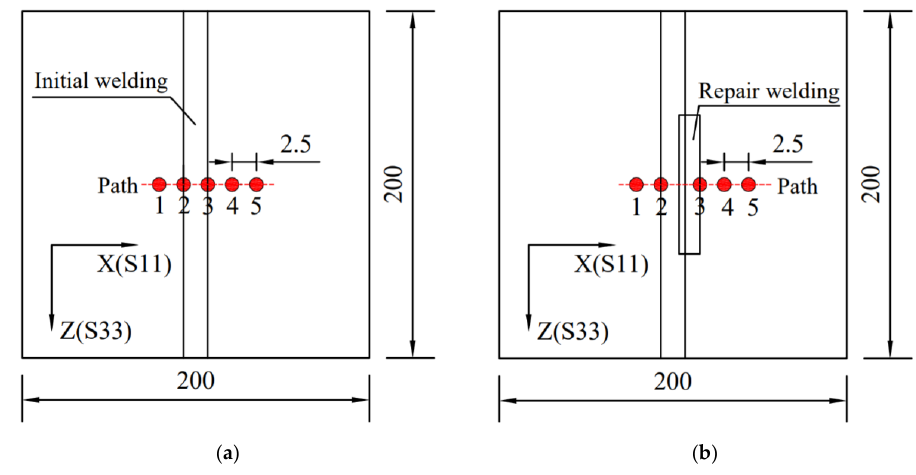
12 of 26 Figure 12. Morphology of specimens: ( a ) after initial welding; ( b ) after repair welding; ( c ) morphology of welding layers. 3.2. Verification of the FE Model After the fabrication of weld repair specimens, the impact indentation strain method [39] was used to measure the residual stress. A spherical indenter was used to generate indentations in the form of impact loads at the location of measuring points. On the one hand, the impact action makes the material appear to have plastic flow deformation. On the other hand, the elastoplastic deformation caused by indentations itself changes under the action of residual stress. The total deformation after superposition of the two kinds of deformation is called strain increment. The relationship between the strain increment generated by the impact indentation strain method and